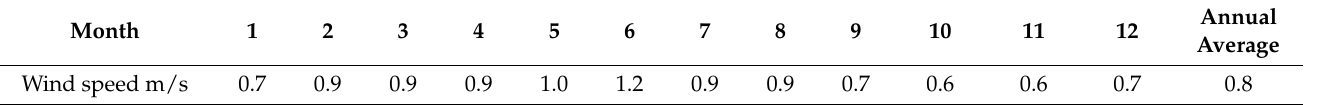
Table 3. Monthly average wind speed from 2017 to